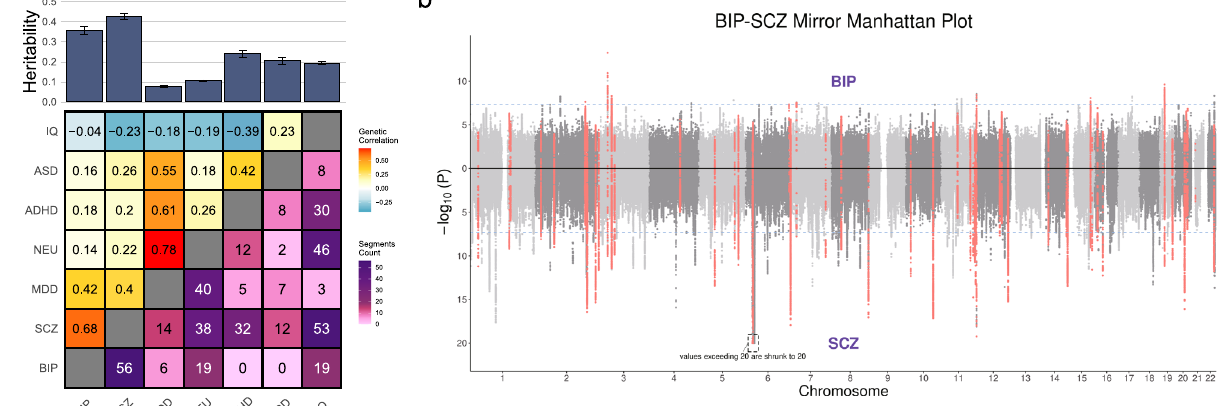
Fig. 3 LOGODetect identi fi es genome regions contributing to multiple neuropsychiatric traits. a Heatmap shows the genetic correlation estimates (upper triangle) and the number of segments with local genetic correlation identi fi ed by LOGODetect (lower triangle) between the seven neuropsychiatric traits; Barplot shows the observed scale heritability estimates and standard errors of the seven traits using LDSC 10 . b Mirrored Manhattan plot for BIP and SCZ. The 56 shared genome regions identi fi ed by LOGODetect are highlighted in red. One locus on chromosome 6 with (cid:2) log 10 P > 20 in SCZ is truncated at 20 for visualization